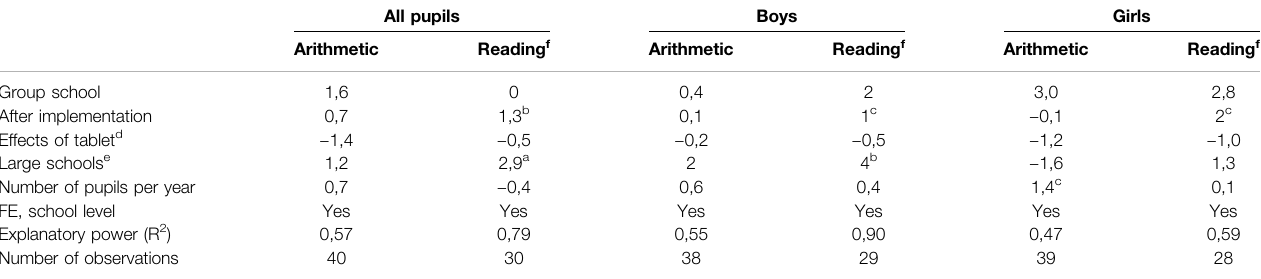
TABLE 8 | Diff-in-diff in fi xed effect regression analysis in 9th grade (group 2). All pupils Boys Girls